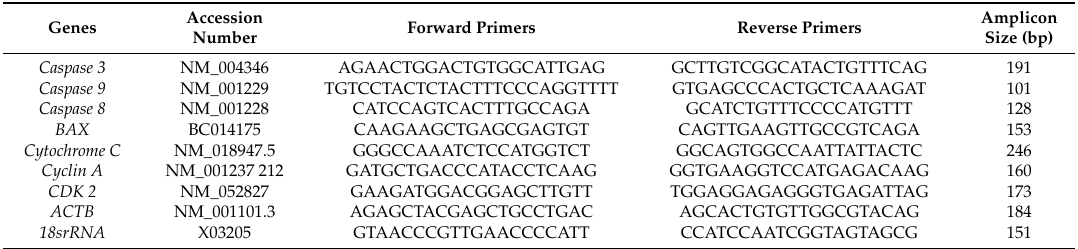
Table 3. The accession number and primer sequence used in gene expression